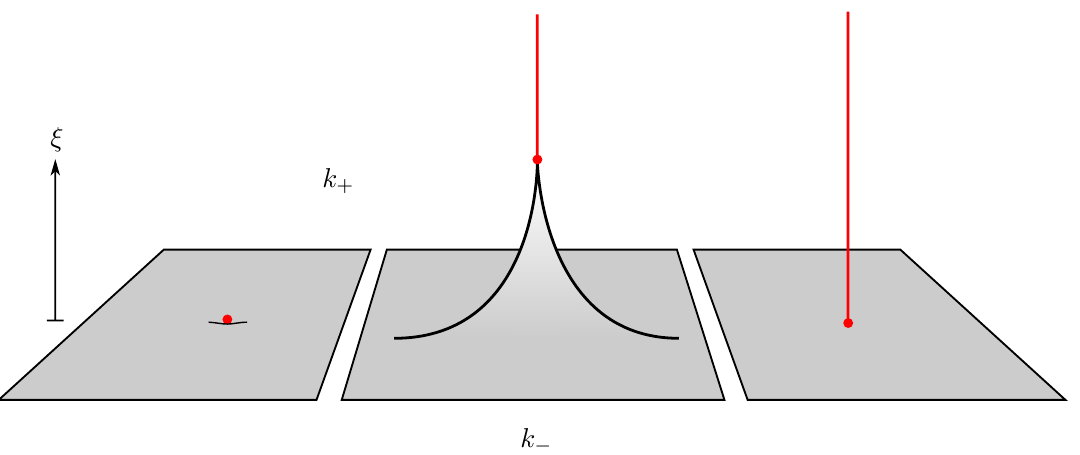
Figure 3. Bending of the brane in response to a matter source placed on it. A matter source placed directly on the brane (as shown in the first panel) bends it “downwards”, giving a negative mass object in four dimensions. A string pulling upwards on the brane (second panel) causes the brane to bend “upwards” i.e., in the direction of increasing ξ and results in a positive mass in four dimensions. Using a gauge transformation, this can be brought into an “unbent” gauge where the brane appears flat and the four dimensional matter source is the end point of the stretched string (as shown in the third